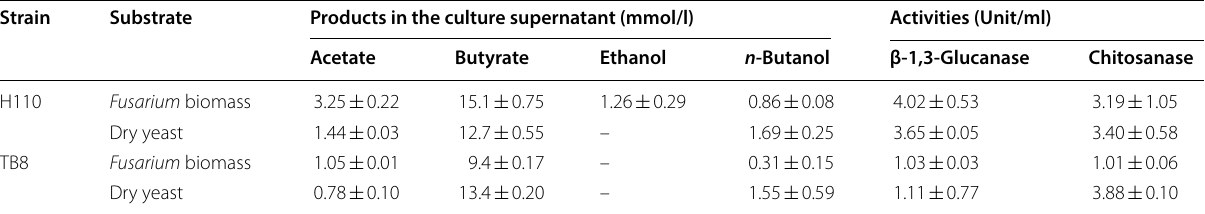
Fusarium biomass, freeze-dried and killed mycelial cells of Fusarium oxysporum f. sp. spinaciae M2-1 Concentration of substrates, 1% (w/v). Products, mean Cultivated for 7 days for both the substrates